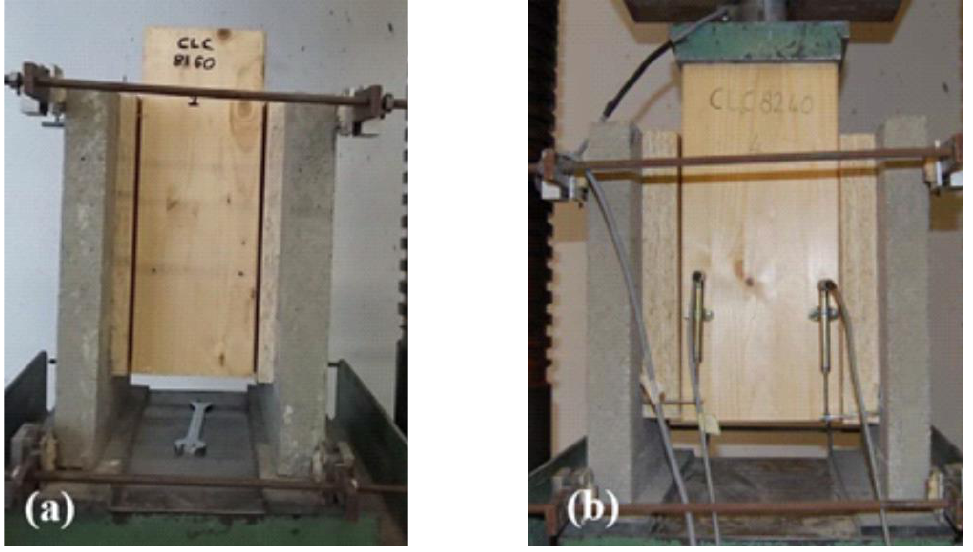
Figure 1. Reference push-out specimens for the experimental tests: ( a ) clc8160 and ( b ) clc8240 series.